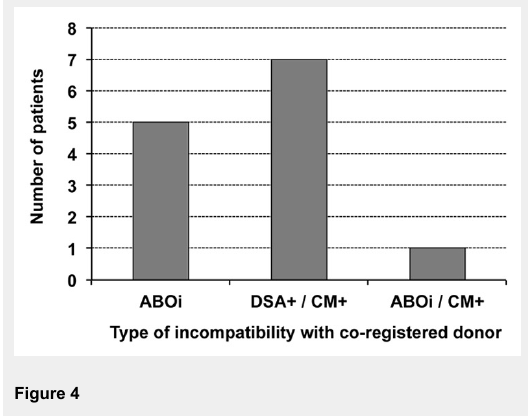
Type of immunological incompatibilities of 13 living donor pairs in Switzerland. ABOi = ABO incompatible; CM+ = positive crossmatch; DSA+ = donor specific